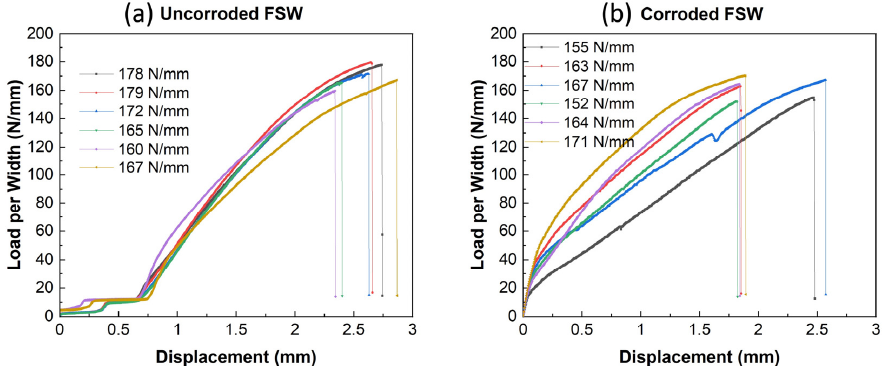
Figure 14. Load-displacement curves of the FSW specimen: ( a ) Uncorroded; ( b ) corroded after eight